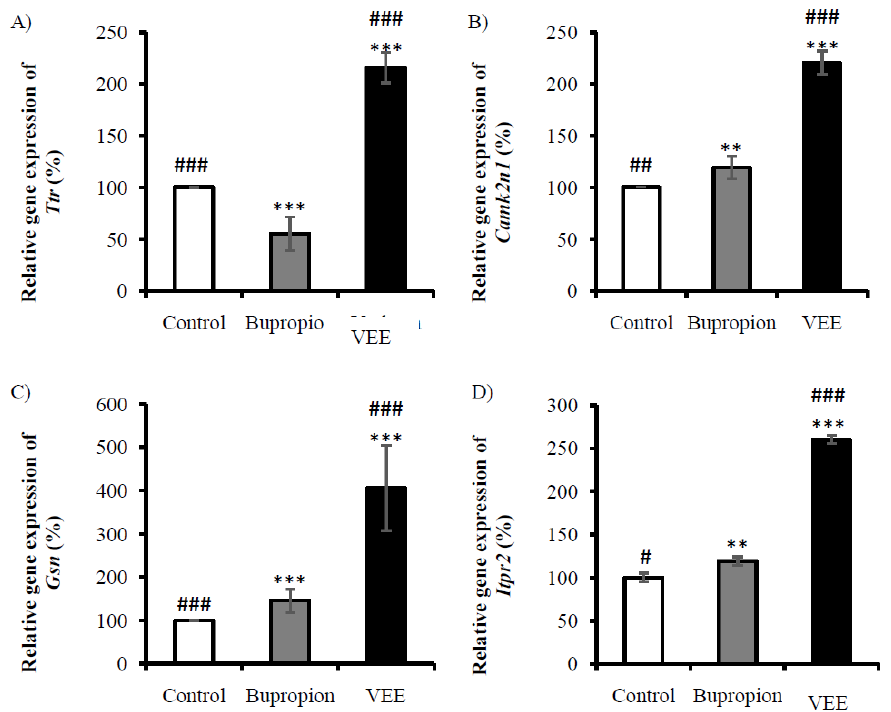
Figure 3. Validation of the expression of genes regulated by VEE treatment (100 mg / Kg) which are ( A ) Ttr , ( B ) Camk2n1 , ( C ) Gsn , and ( D ) Itpr2 . Results were expressed in relative gene expression ± SD. * P < 0.05; ** P < 0.001; *** P < 0.0001 compared with negative control group. # P < 0.05; ## P < 0.001; ###